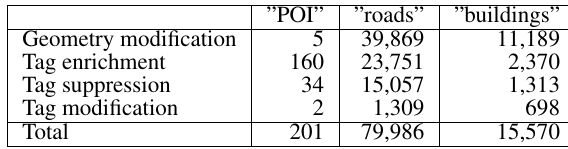
Table 1. Number of modifications for each type in the ”POI”, ”roads” and ”buildings”